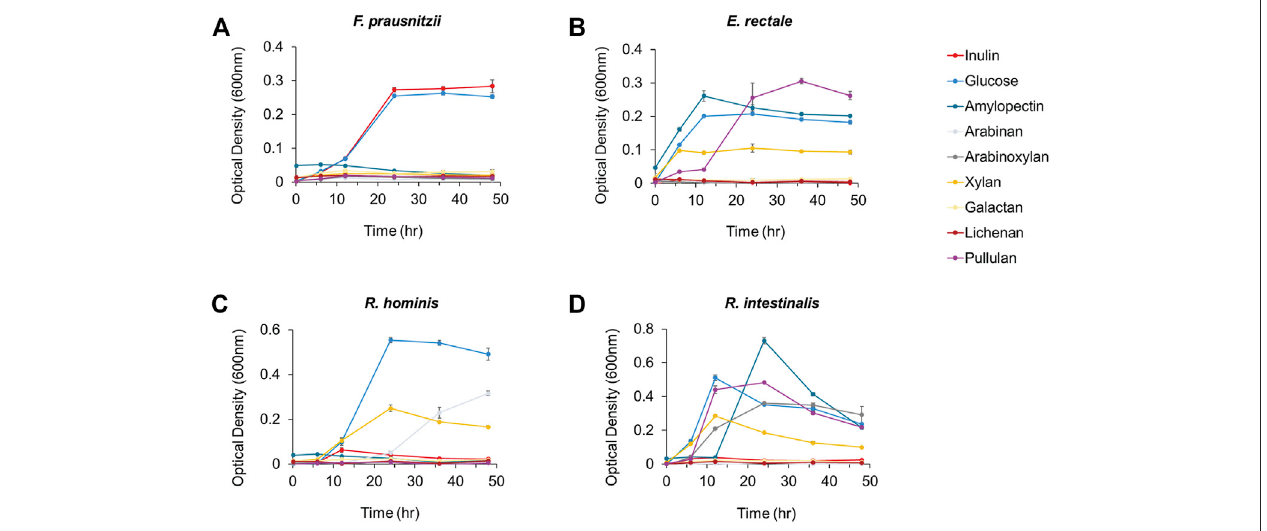
FIGURE 1 | The growth analysis of butyrate-producing bacteria (A) F. prausnitzii (B) E. rectale (C) R. hominis and (D) R. intestinalis cultured in mYCFA supplementedwitheitherinulin,glucose,amylopectin,arabinan,arabinoxylan,xylan,galactan,lichenan,orpullulan.Allexperimentswereperformedintriplicatesforeach